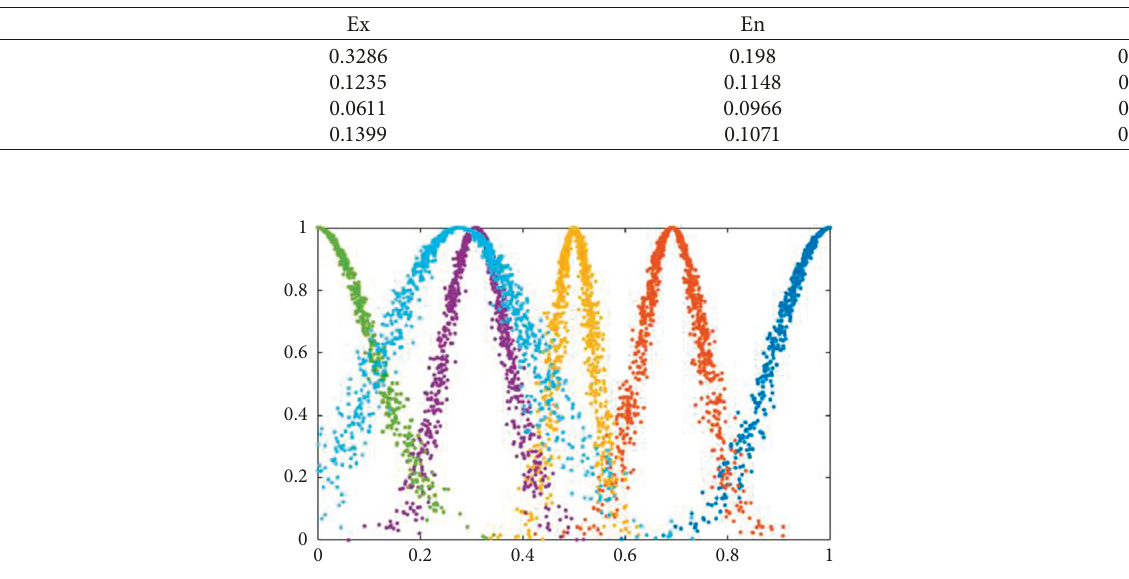
Table 14: Cloud digital characteristics of the first-level index.